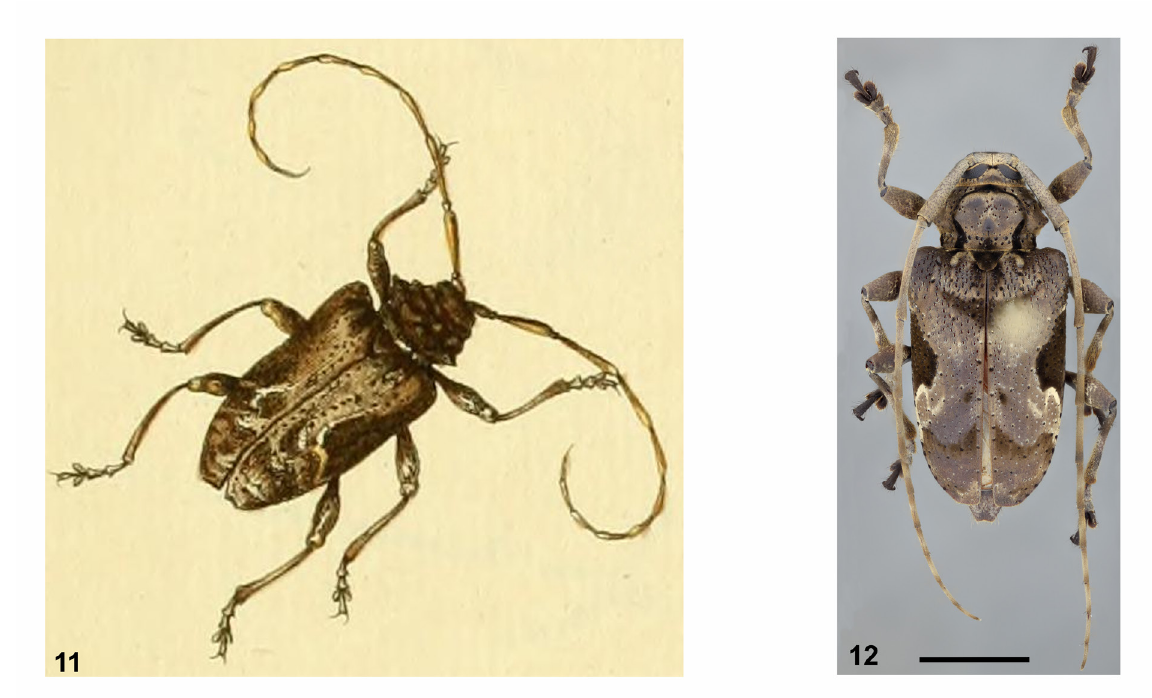
12 . Female from Honduras (RBINS). Dorsal habitus. Scale bar = 5.0